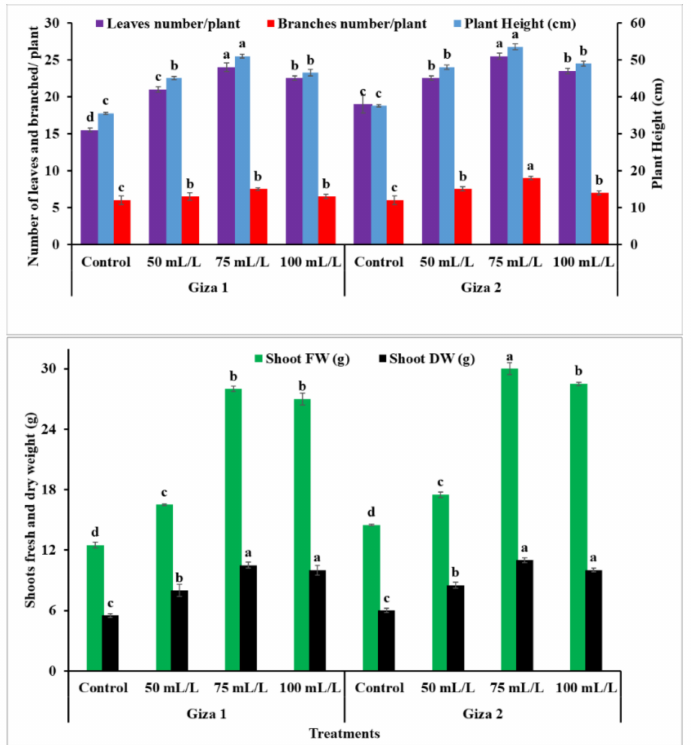
Figure 1. Effect of four active yeast extracts (AYE) exogenous applications on numbers of leaves and branches per plant and plant height (upper graph); and shoots fresh and dry weight (lower graph) of two lupine cultivars grown in reclaimed-saline soil. For each parameter, treatments followed by the same letter are not significantly differed at p ≤ 0.05. Error bars are ± Standard Error